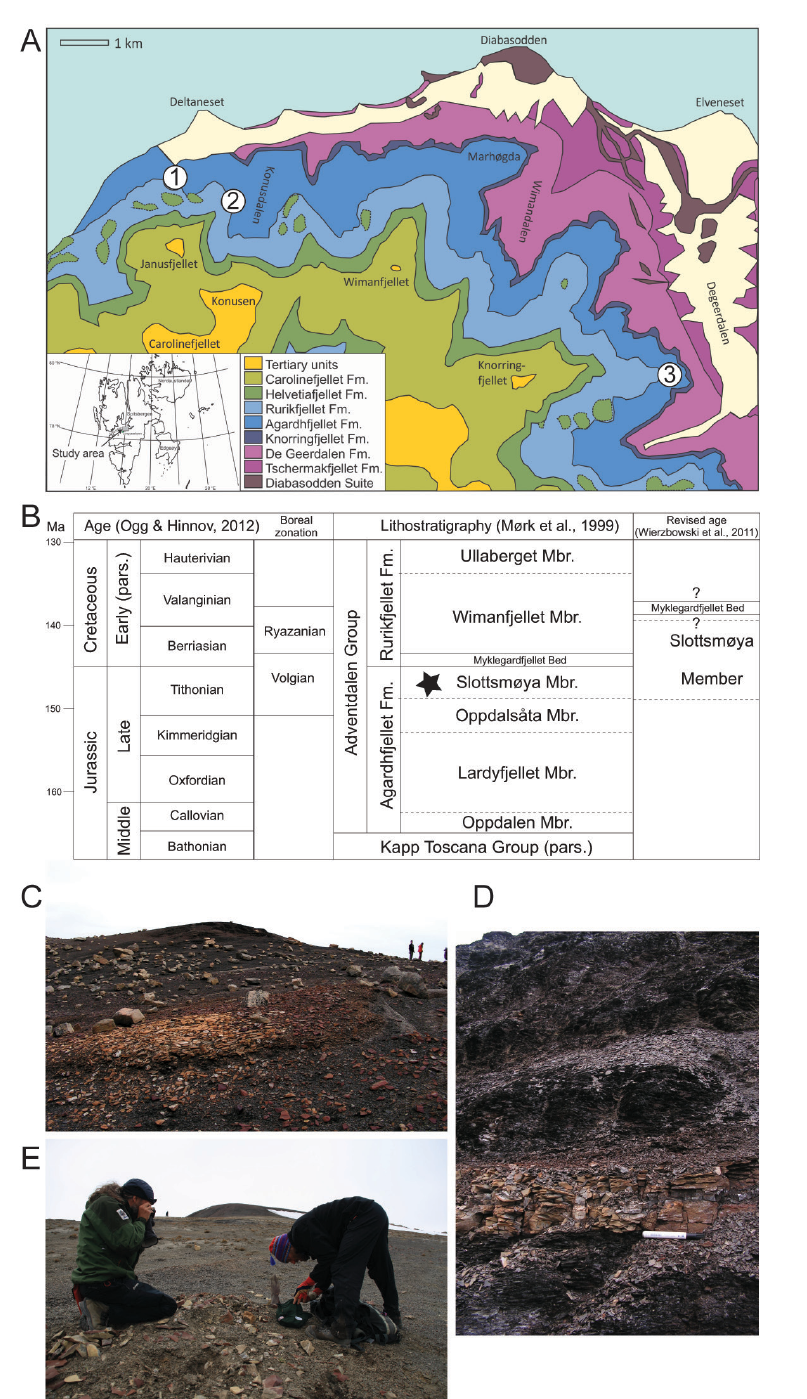
Fig. 1. A . Simplified geological map of the study area in Sassenfjorden, central Spitsbergen, with location of the Janusfjellet (1), Konusdalen (2) and Knorringfjellet (3) collection sites. Redrawn and adapted from Dallmann et al. (2001) by H.A. Nakrem, used with permission. B . Chrono- and lithostratigraphic correlation for the Late Jurassic-Earliest Cretaceous interval of central Spistbergen. The Slottsmøya Member is indicated by a star. Modified with permission from Dalseg et al. (2016). C . Janusfjellet locality, 78°20′35.4″ N, 15°49′85.2″ E, surface outcrop. D . Konusdalen locality, 78°19′97.1″ N, 15°52′15.5″ E, in situ layer. E . Knorringfjellet locality, N 78° 18’ 04.4” E 16° 16’ 02.0”,